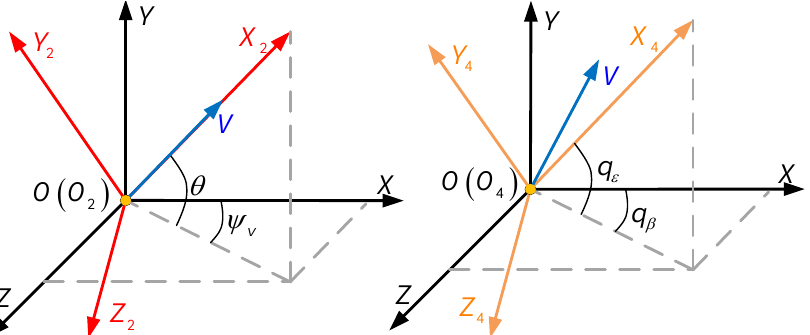
Figure 1. Conversion relationship between S 0 , S 2 , and S 4 ( Left : S 0 and S 2 . Right : S 0 and S 4 ). V is the velocity vector of the aircraft, θ is the flight path angle, ψ v is the heading angle, and q (cid:101) and q β are the LOS